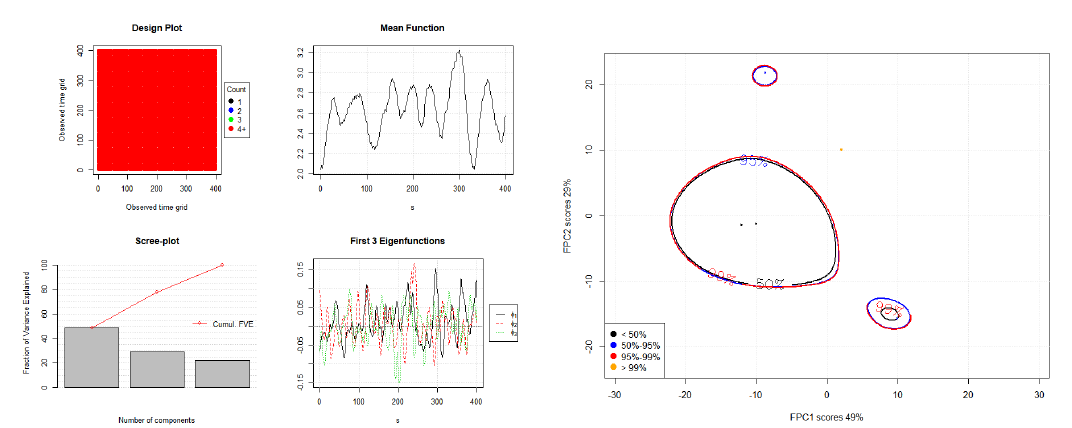
Figure 3. FPCA Plots of X 2 .